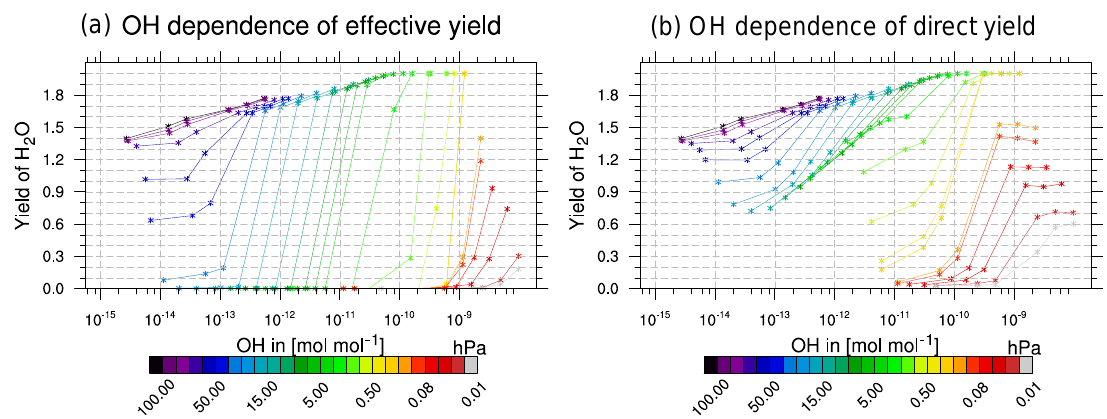
Figure 7. Effective yield (a) and direct yield (b) versus OH; colors indicate pressure level from low to high pressure.